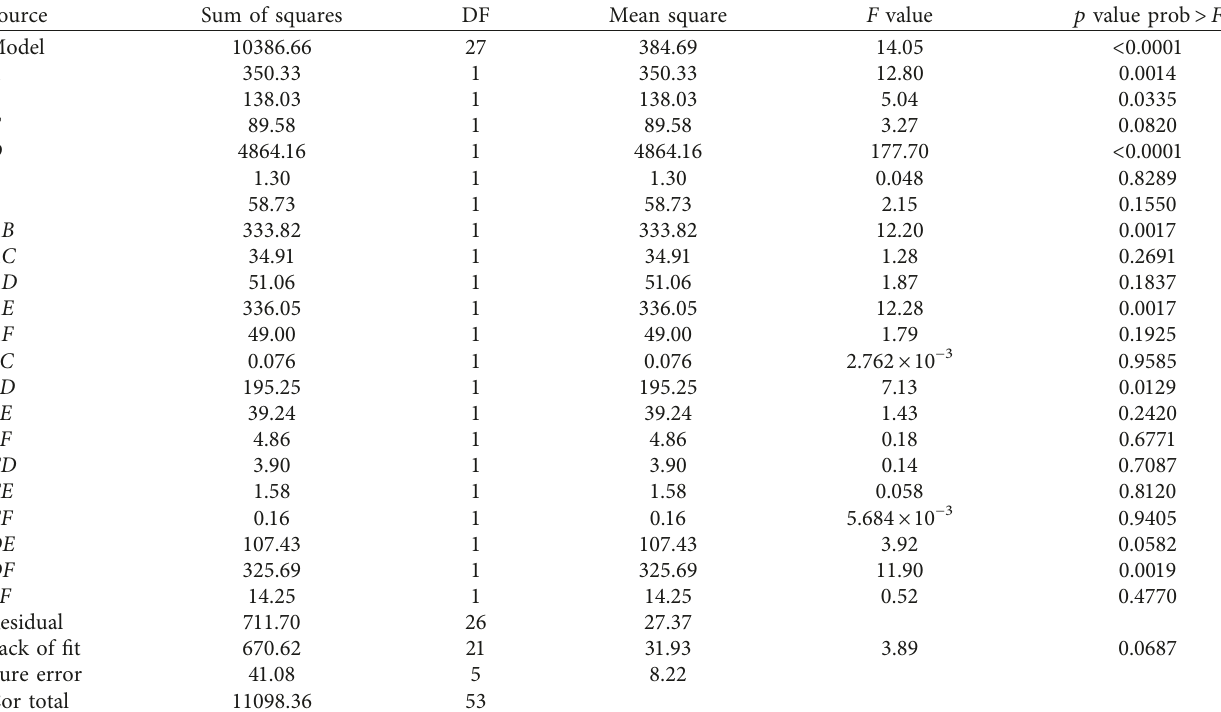
Table 7: Analysis of variance of